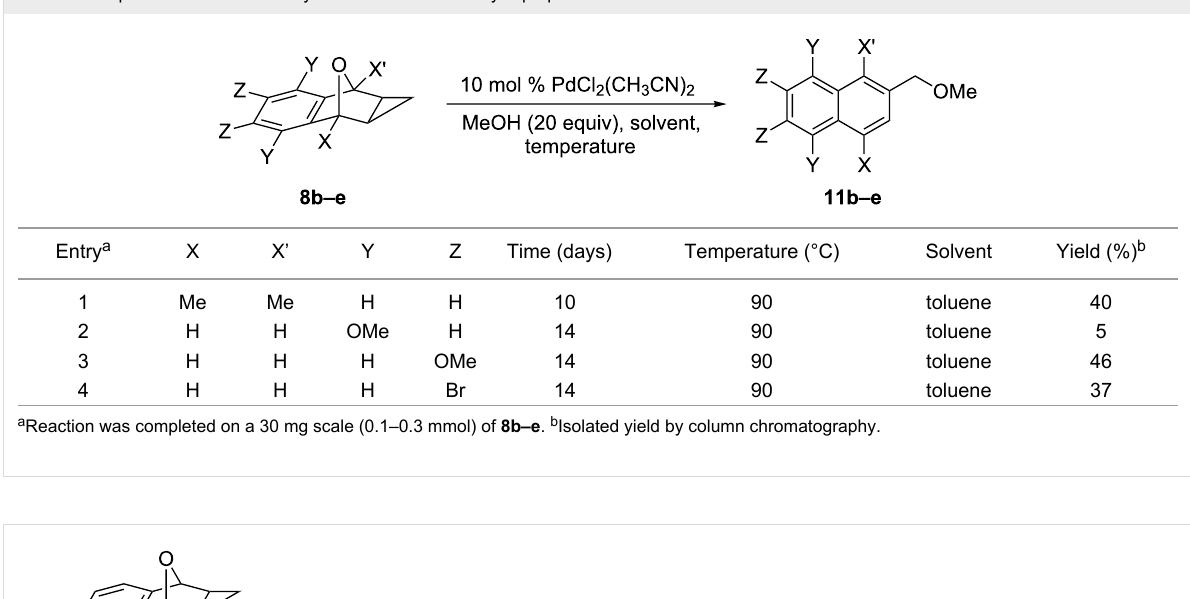
Table 3: Scope of the reaction with symmetrical substituted cyclopropanated 7-oxabenzonorbornadiene.